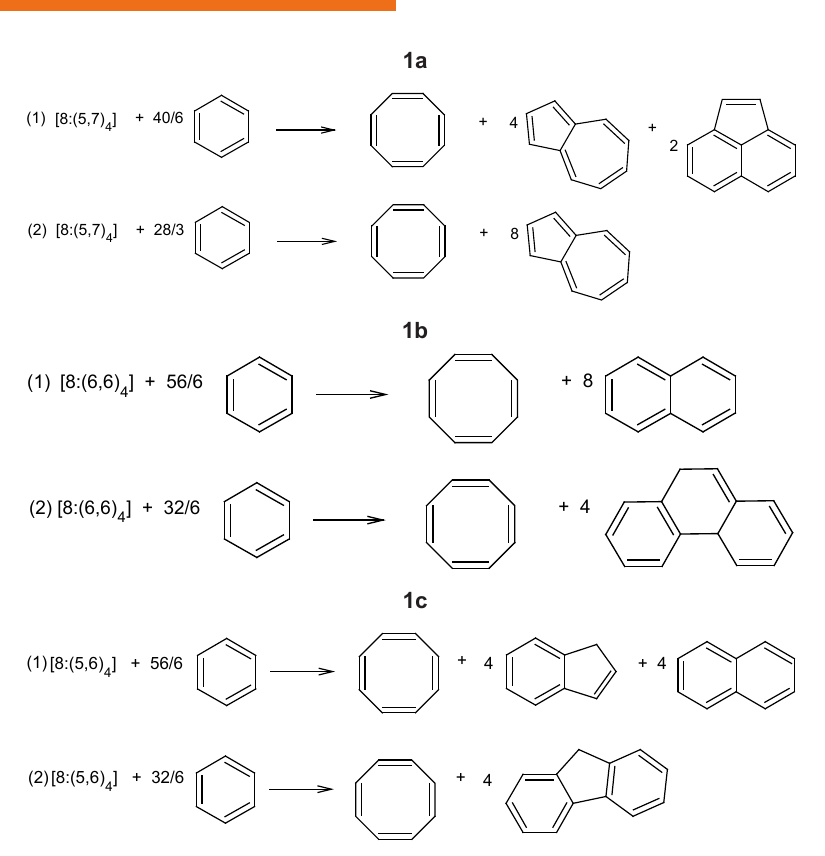
Figure 2. (cid:44)(cid:86)(cid:82)(cid:71)(cid:72)(cid:86)(cid:80)(cid:76)(cid:70)(cid:3)(cid:85)(cid:72)(cid:68)(cid:70)(cid:87)(cid:76)(cid:82)(cid:81)(cid:86)(cid:3)(cid:73)(cid:82)(cid:85)(cid:3)(cid:87)(cid:75)(cid:72)(cid:3)(cid:72)(cid:81)(cid:87)(cid:75)(cid:68)(cid:79)(cid:83)(cid:92)(cid:3)(cid:70)(cid:68)(cid:79)(cid:70)(cid:88)(cid:79)(cid:68)(cid:87)(cid:76)(cid:82)(cid:81)(cid:3)(cid:76)(cid:81)(cid:3)(cid:288)(cid:82)(cid:90)(cid:72)(cid:85)(cid:86)(cid:3) 1a to 1c